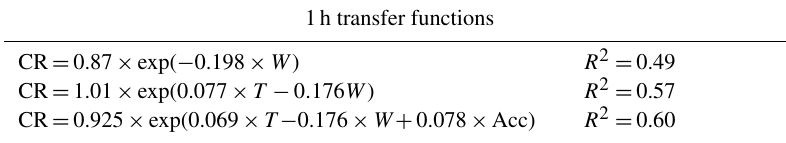
Table 3. Derived transfer functions in which each step adds a new variable. Top table is for 1h period and bottom table is for 3h period. The value of the coefficient of determination ( R 2 ) increases with more variables and longer periods. The number of data points used in the analysis were 214 and 87, for 1h period and 3h period respectively. Equations (4) and (8) were used to correct the data as explained in Sect. 3.1. Variables: CR is catch ratio, T is temperature ( ◦ C), W is wind speed (ms − 1 ), Acc is accumulation